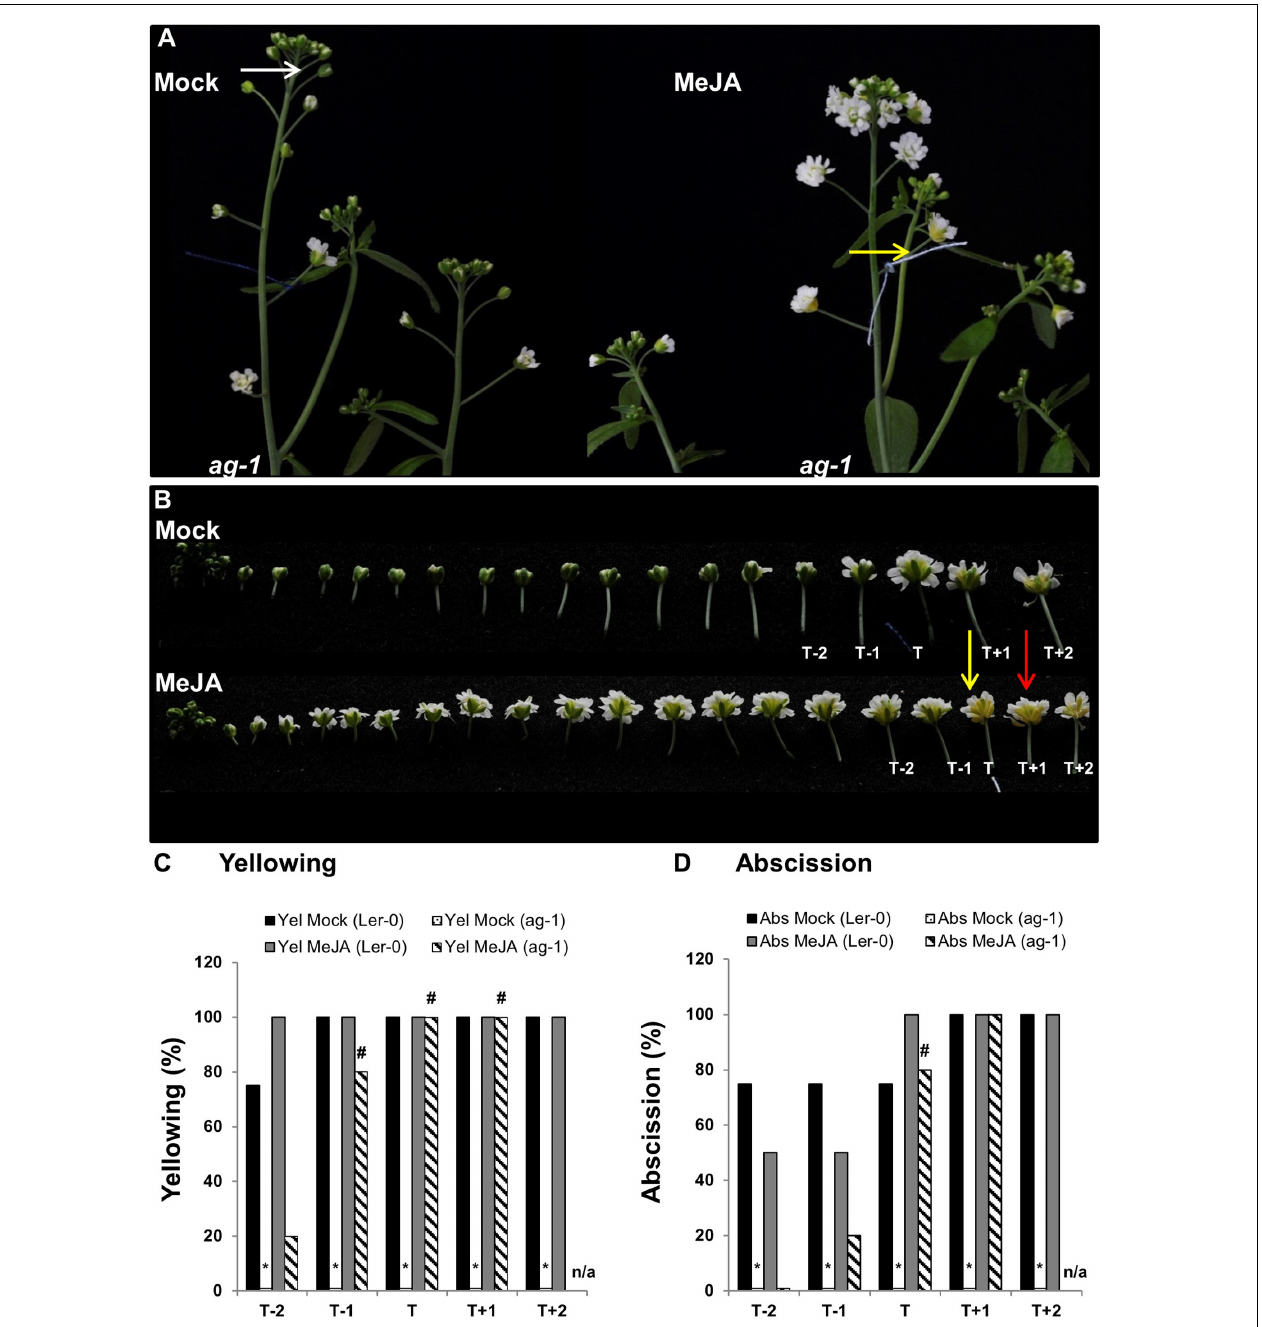
FIGURE 4 | Exogenous application of MeJA to ag-1 flowers. (A) Mock- and 100 µ M MeJA-treated ag-1 plants. Plants were grown under long-day conditions for 6 weeks and sprayed once a day with mock or MeJA solutions for 3 days. Flower buds with visible white petals were tagged with a cotton thread at day 0 of the MeJA or mock treatments and inflorescences were photographed after 3 days of treatment. (B) Flowers of mock- and 100 µ M MeJA-treated ag-1 inflorescences were detached and photographed. (C) Percentage sepal yellowing of Mock- and MeJA-treated ag-1 and L er -0 flowers. (D) Percentage sepal abscission of Mock- and MeJA-treated ag-1 and L er -0 flowers. White arrow indicates floral bud at stage 13 (Alvarez-Buylla et al., 2010), yellow arrows indicate flowers with senesced sepals, and red arrow indicates a flower with abscised sepals. T represents the tagged flower, T − 1 and T − 2 represent flowers younger than T, T + 1 and T + 2 represent flowers older than T. 0% datapoints are placed slightly above the X-axis. Statistical differences between mock treated wild type and mutants (indicated by ∗ ) and mock- and MeJA-treated mutant plants (indicated by # ) were calculated according to the Wilson score confidence limits for a percentage as calculated in Agresti and Coull, 1998 (Supplementary Table S2). The photographs shown are representatives of three ( C,D ; MeJA treated T + 1 and T + 2 ) or four to six biological replicates. Sen, Senescence; Abs, Abscission, n/a, not applicable.